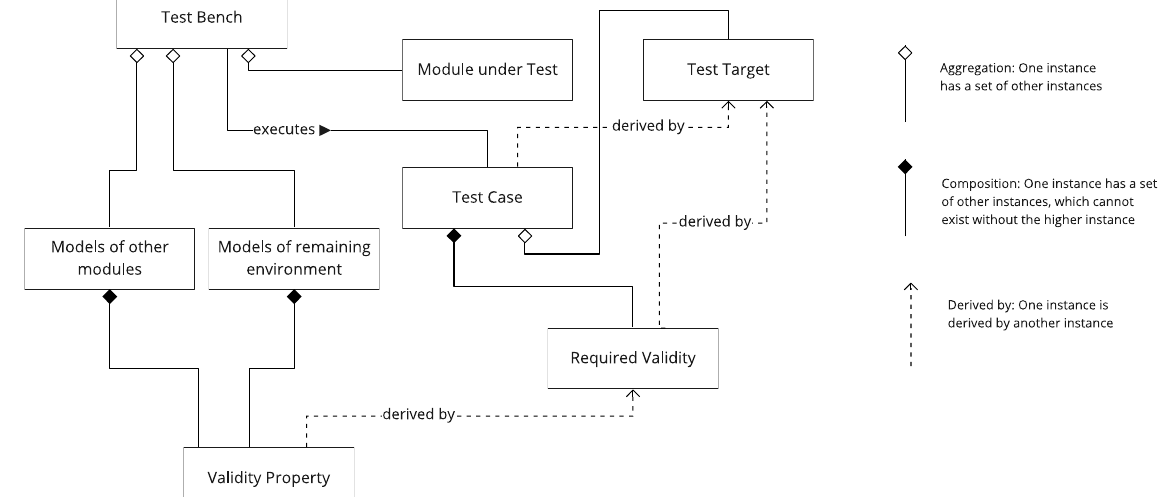
Figure 6. Dependencies between test case and validity, visualized as UML class diagram.